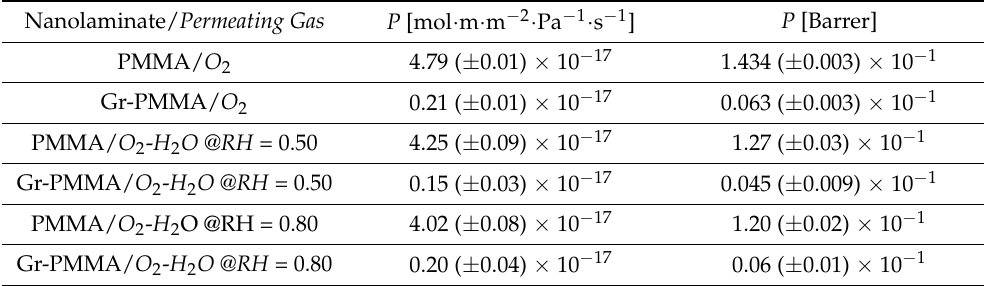
Table 2. Permeability coefficients of O 2 through the nanolaminates at different R.H.